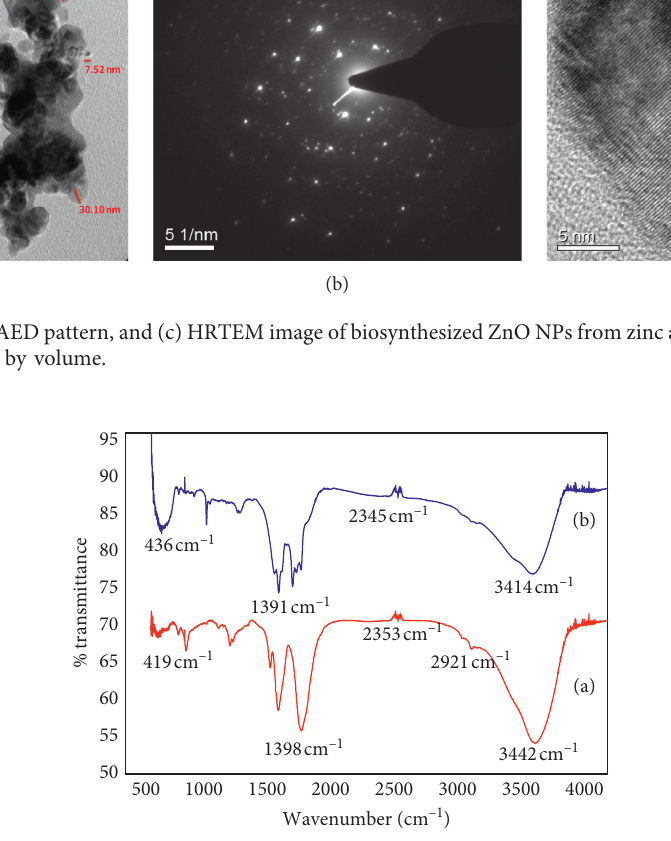
Figure 6: FTIR spectra of (a) uncalcinated and (b) calcinated ZnO NPs synthesized from zinc acetate dihydrate and Lippia adoensis leaf extract with 1:1 ratio by volume.